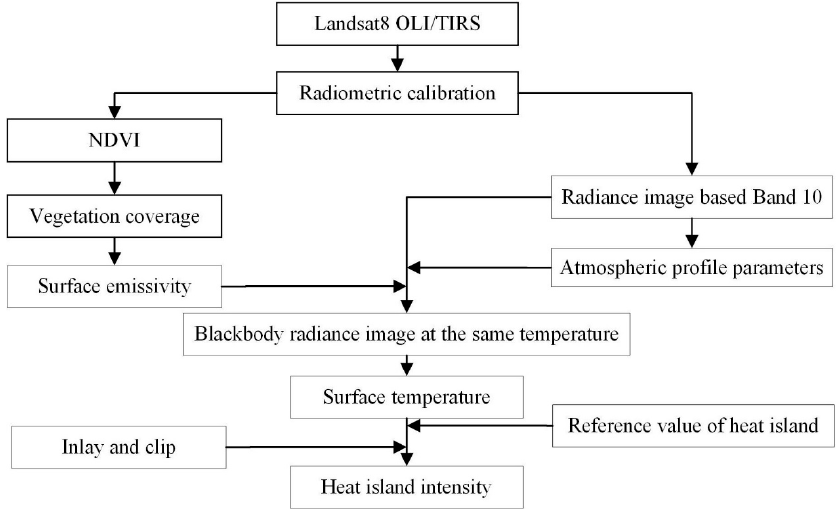
Figure 3. The process of surface heat island data inversion.